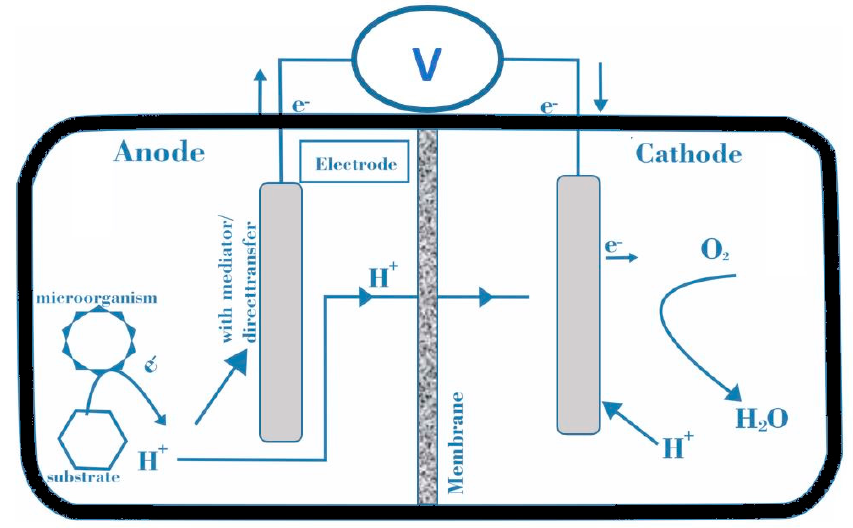
Figure 8. Schematic diagram of MFC [213].